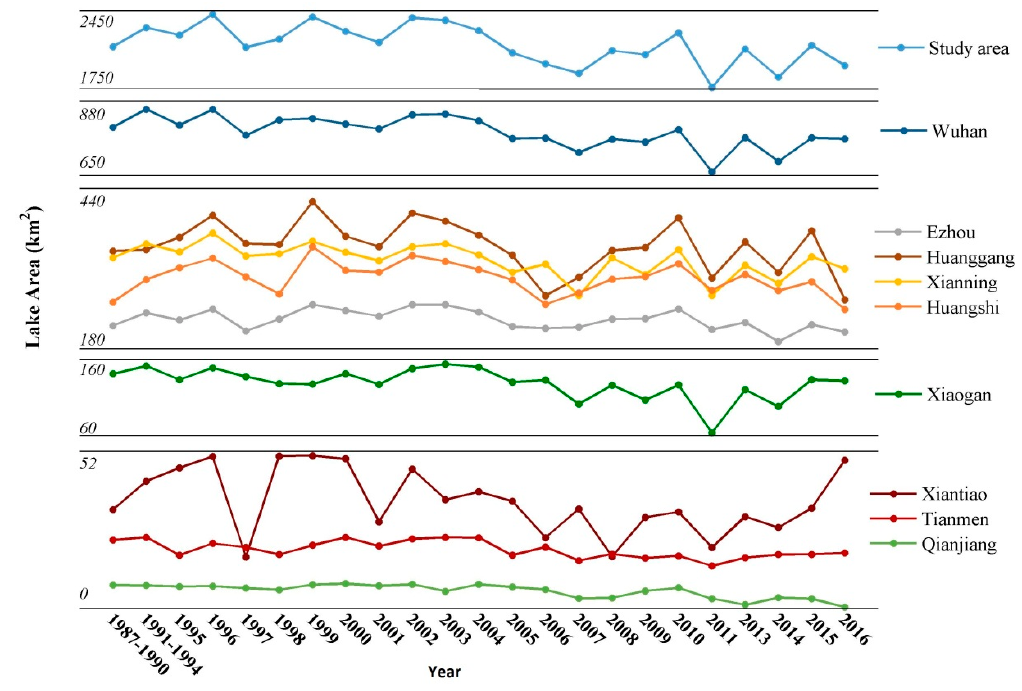
Figure 6. Lake water extent changes from 1987~2015.